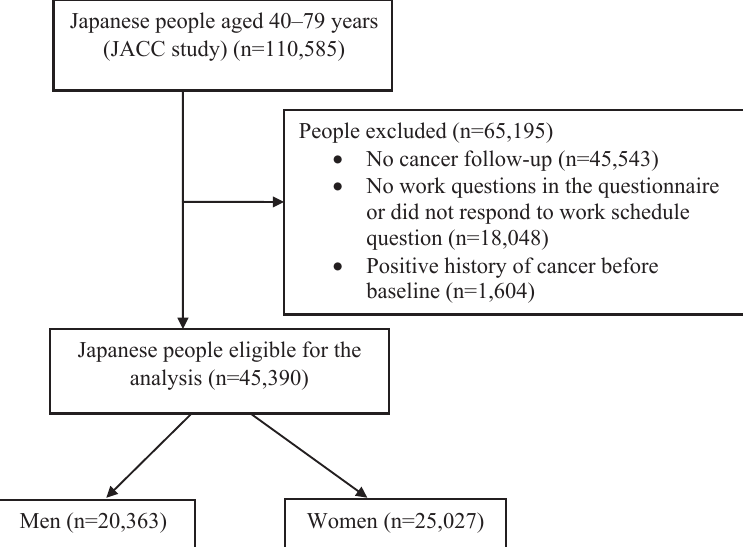
Figure 1. Flow chart of the study population eligibility